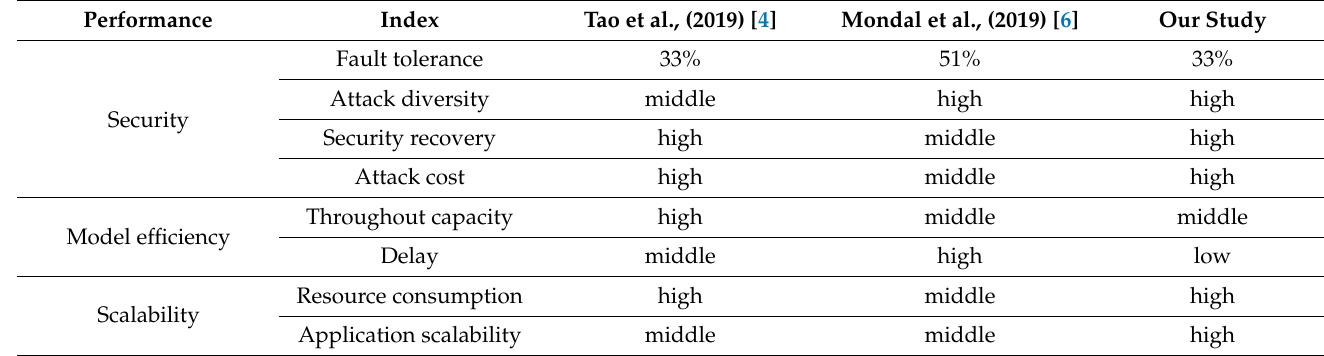
Table 3. Comparative analysis